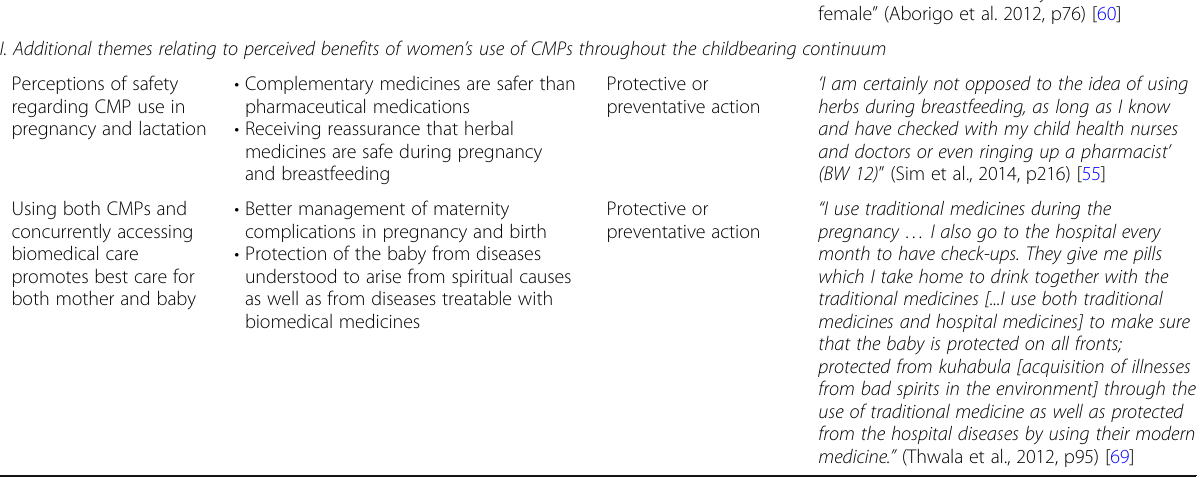
The women in this study used both the medicinal and supernatural properties of Nat leaves to treat the mind – heart essence ” (Elter et al., 2016, p253) [58] Facilitation of a normal